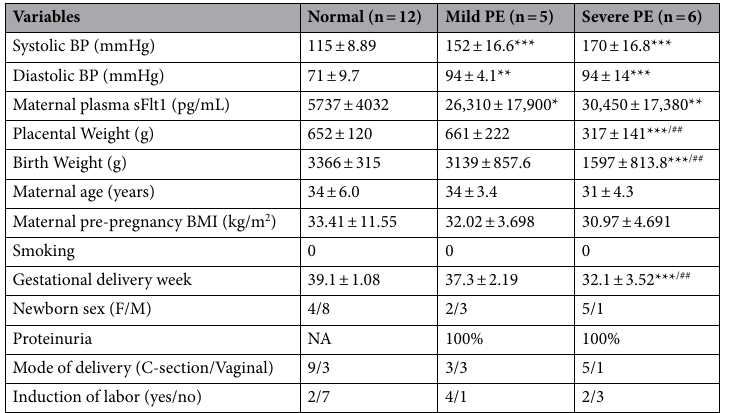
Table 1. Characteristics of the study population at delivery. Data are presented as mean ± SEM. Patient variables were analyzed by one-way ANOVA followed by Tukey’s multiple comparison. * P < 0.05, ** P < 0.01, *** P < 0.001 for mild PE versus normal or severe PE versus normal; # P < 0.05, ## P < 0.01, ### P < 0.001 for severe PE versus mild PE. Proteinuria measurement was based on a combination of 24 h urine test and protein/ creatinine ratio. BP blood pressure, BMI body mass index, NA not